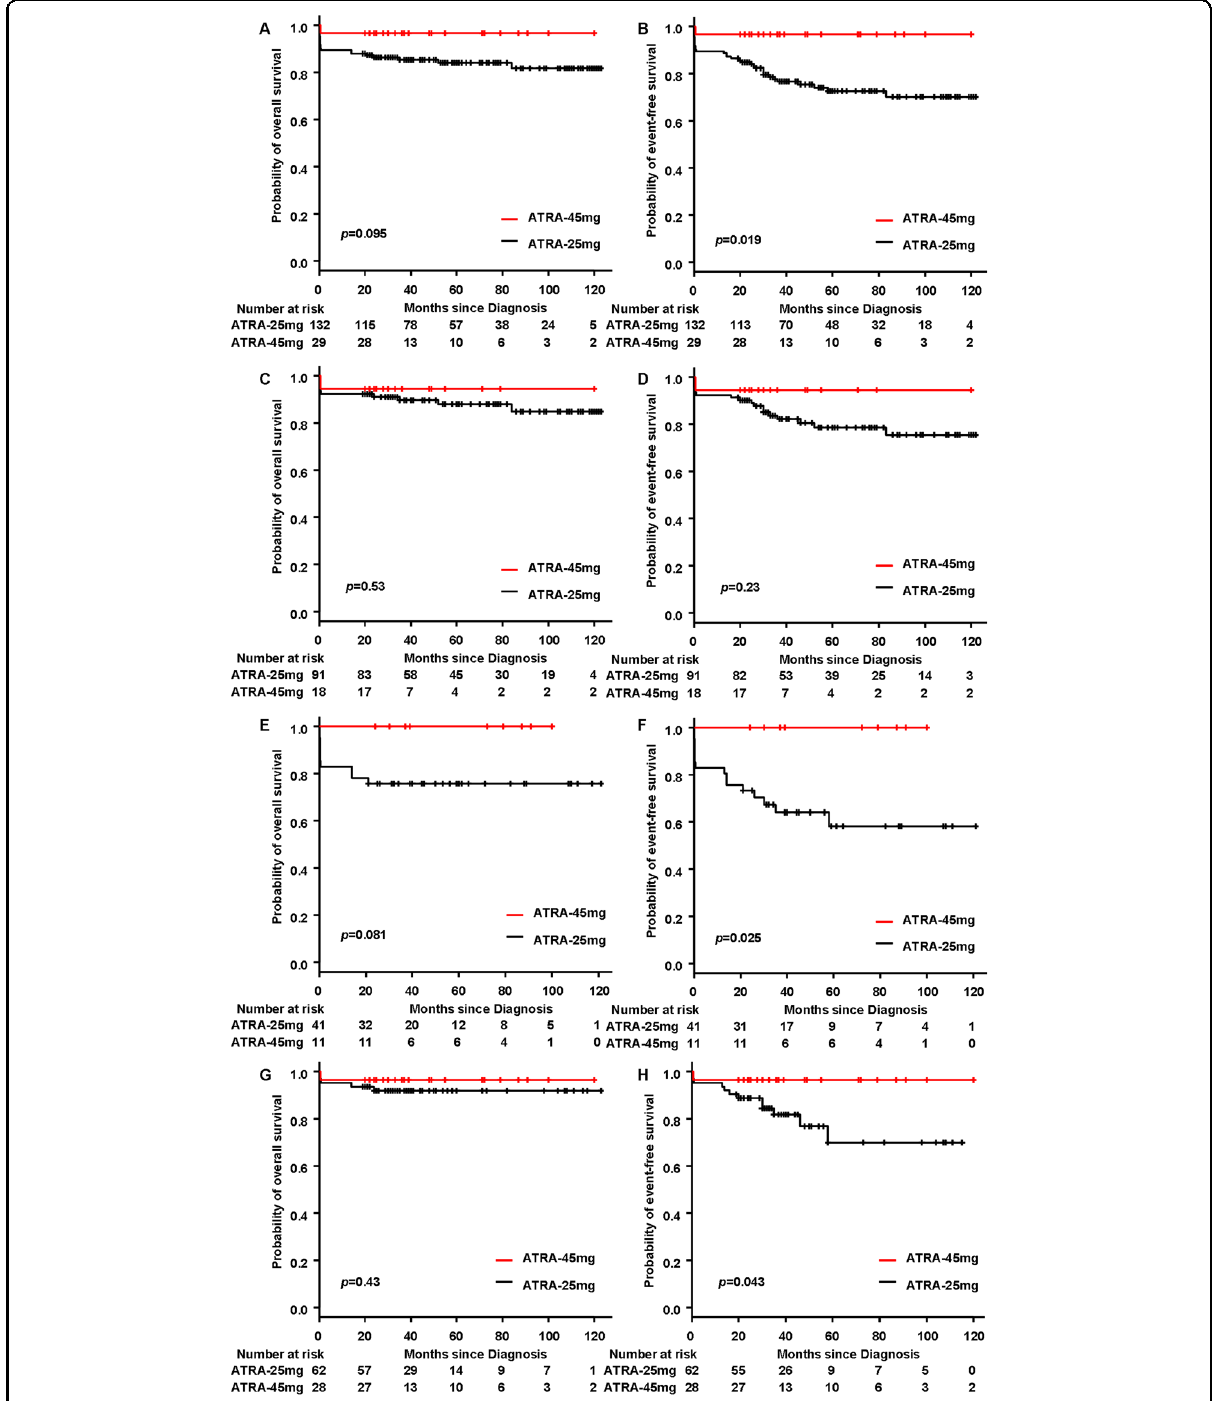
Fig. 1 Overall survival and event-free survival. A Overall survival (OS) for the whole cohort. B Event-free survival (EFS) for the whole cohort. C OS for low- or intermediate-risk patients. D EFS for low- or intermediate-risk patients. E OS for high-risk patients. F EFS for high-risk patients. G OS for patients receiving ATRA plus ATO. H EFS for patients receiving ATRA plus